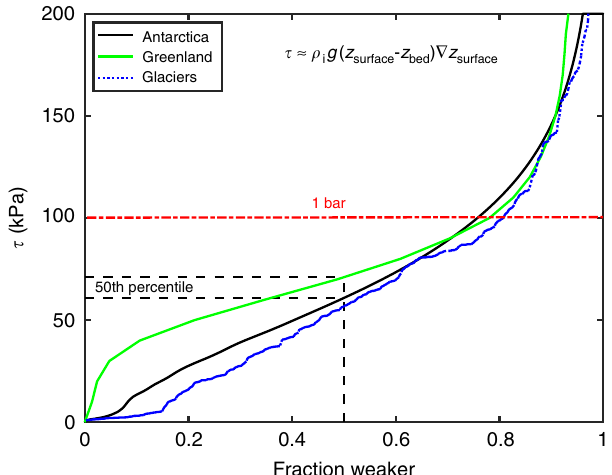
Fig. 1 Driving stress for glaciers and ice sheets. Average driving stress for Antarctica (black) and Greenland (green) plotted as a function of the fractional area that is weaker. Antarctic values were calculated from BEDMAP2 data reported on a 1 km grid 30 . Greenland values were extracted from MacGregor et al. 6 based on surface slopes from GIMP 31 and ice thicknesses from Morlighem et al. 27 . Also, shown for comparison (dotted blue) are approximate shear stress values calculated from average thicknesses and slopes (not colocated) plotted as the proportion weaker among 449 pairs of these parameters tabulated for Alpine glaciers in the GlaThiDa data set